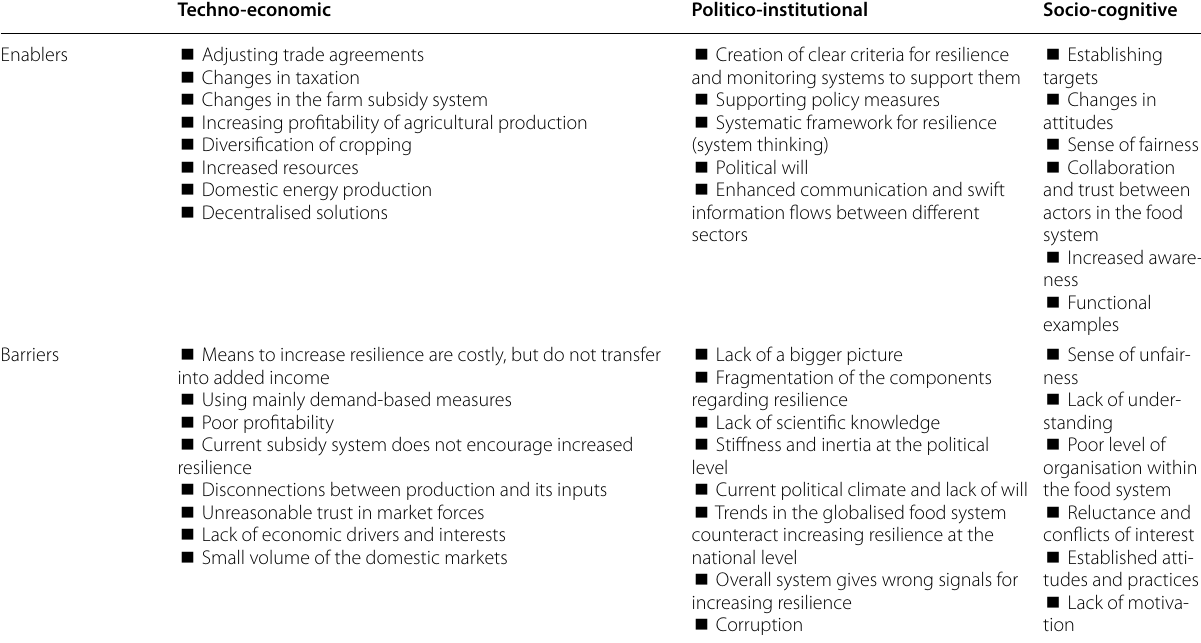
Table 4 Expert views of enablers and barriers for food system resilience. Results of open-ended